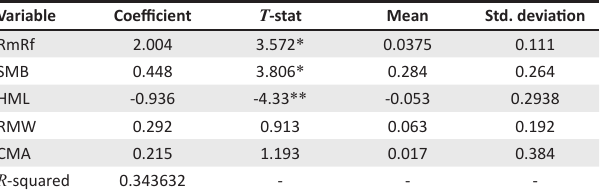
TABLE 1: Regression results and descriptive statistics for the Fama and French five-factor model. Variable